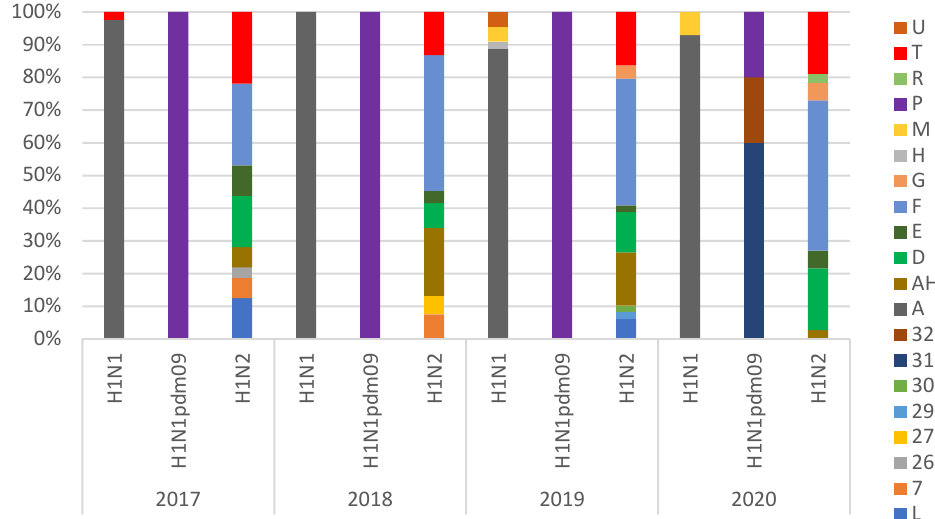
Figure 1. Percentage of genotypic diversity of H1 swIAV Italian strains per year detected between 2017 and 2020. Genotype identification is described in Tables 3 and 4. Strains were classified in subtypes: H1N1 (HA-1B/HA-1C-N1), H1N1pdm09 (HA-1A-N1), H1N2 (HA-1A/HA-1B/HA-1C-N2).